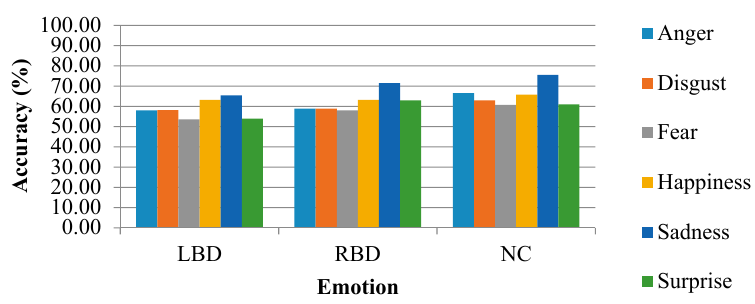
Figure 14. The accuracy of each emotional state using the KNN classifier.